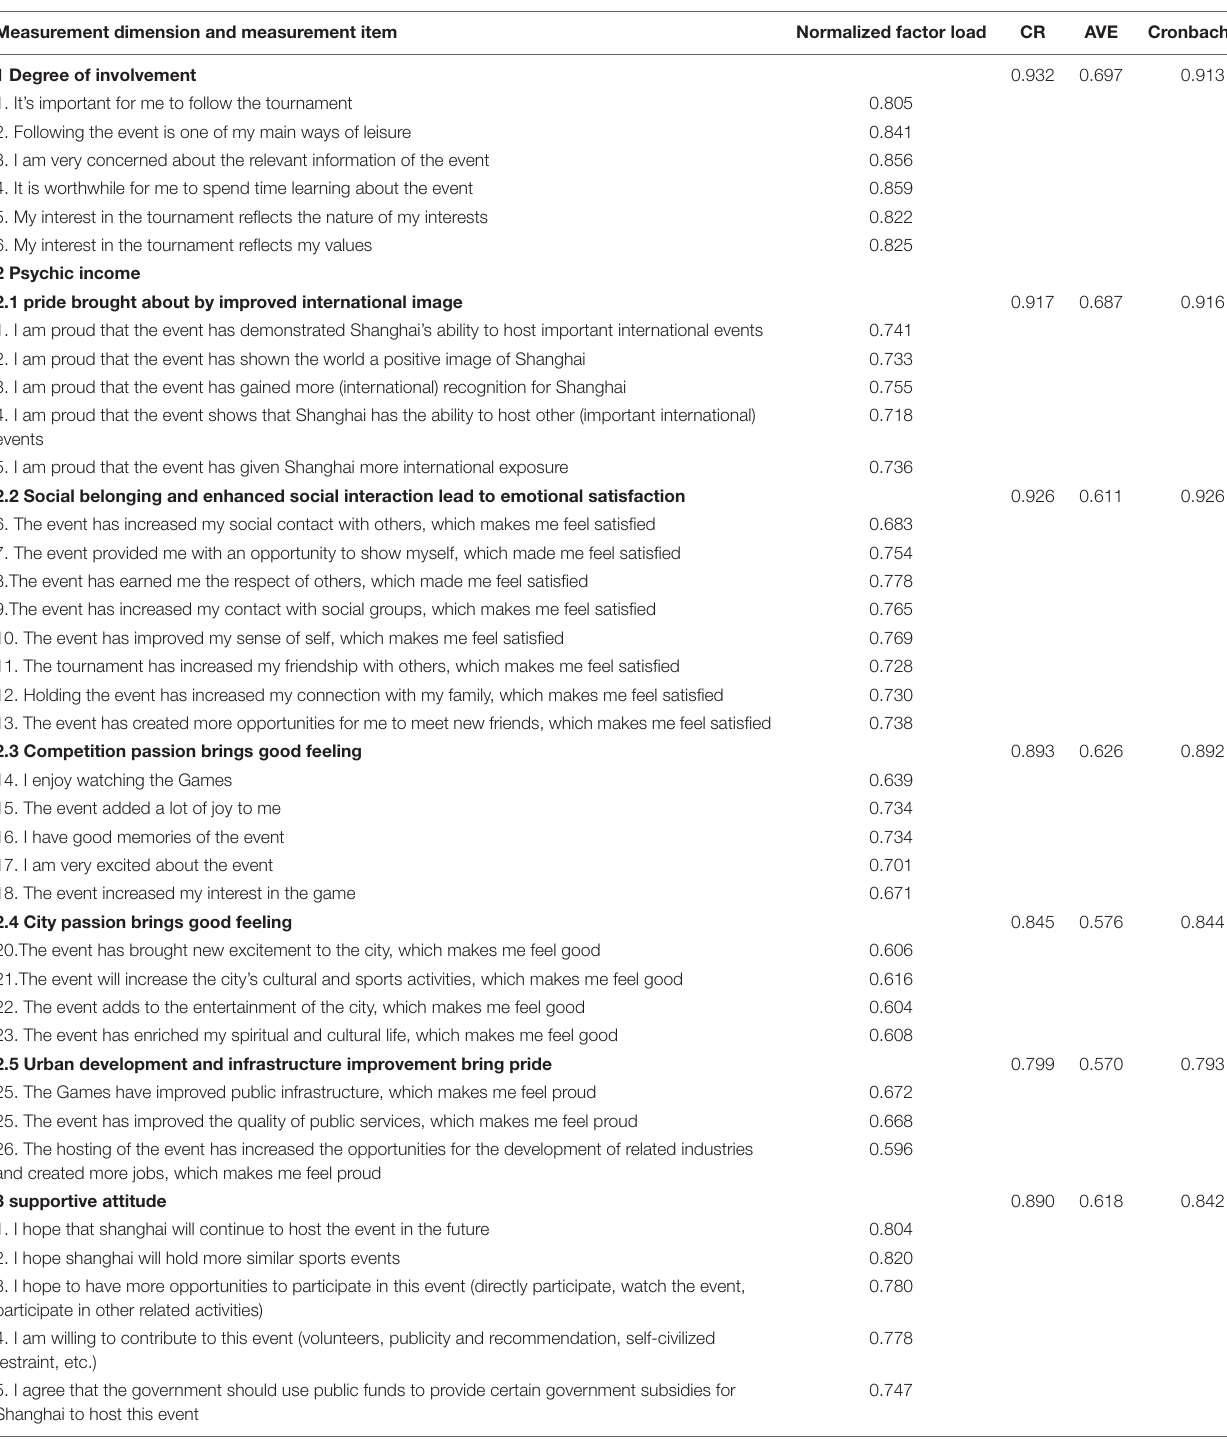
TABLE 3 | Analysis of reliability and convergence validity. Measurement dimension and measurement